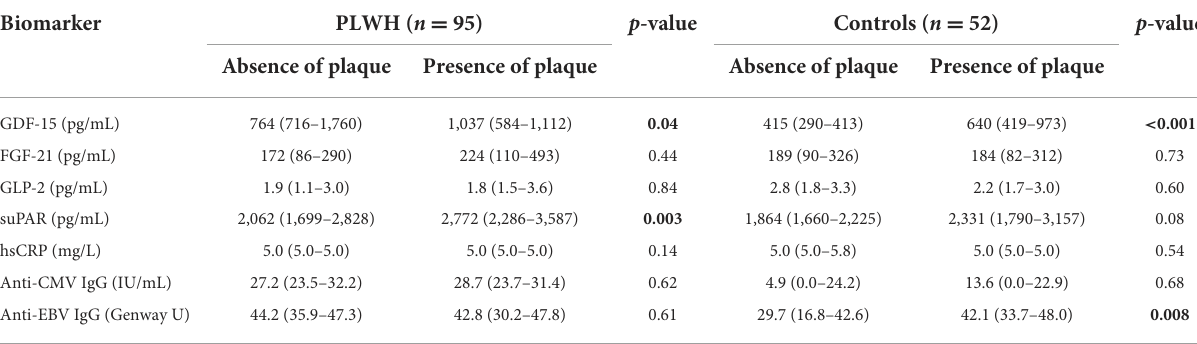
TABLE 2 Plasmatic levels of tested biomarkers in people living with HIV and controls depend on the absence or presence of coronary plaque. Biomarker